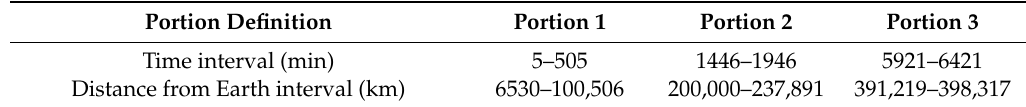
Table 3. Statistics for the number of available observations.